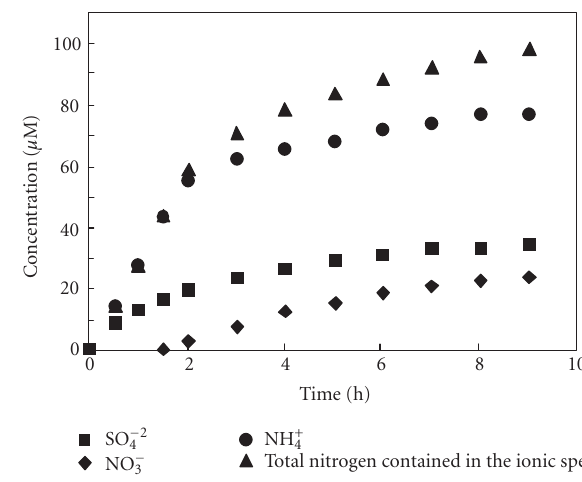
Figure 5: Time evolution of the organic ionic species formed dur- ing the photocatalytic degradation of a 20mgL − 1 aqueous solution of lincomycin.